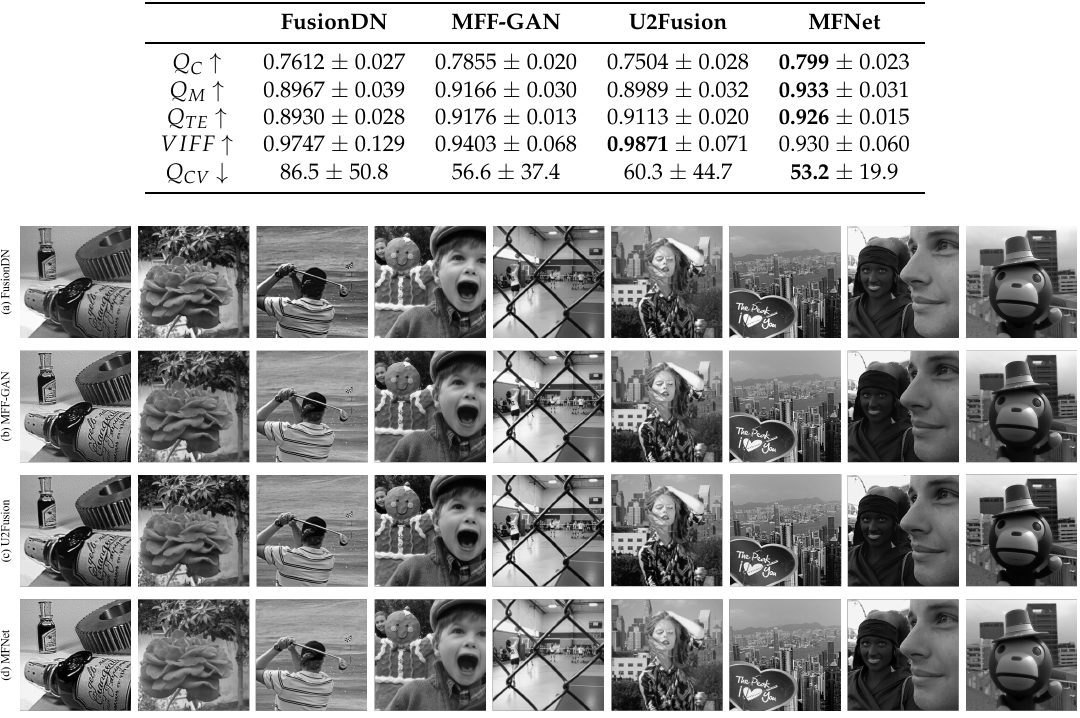
Table 2. Comparison of the mean and standard deviation ( ± SD) of five evaluation metrics between the unsupervised MFNet and the state-of-the-art unsupervised networks.